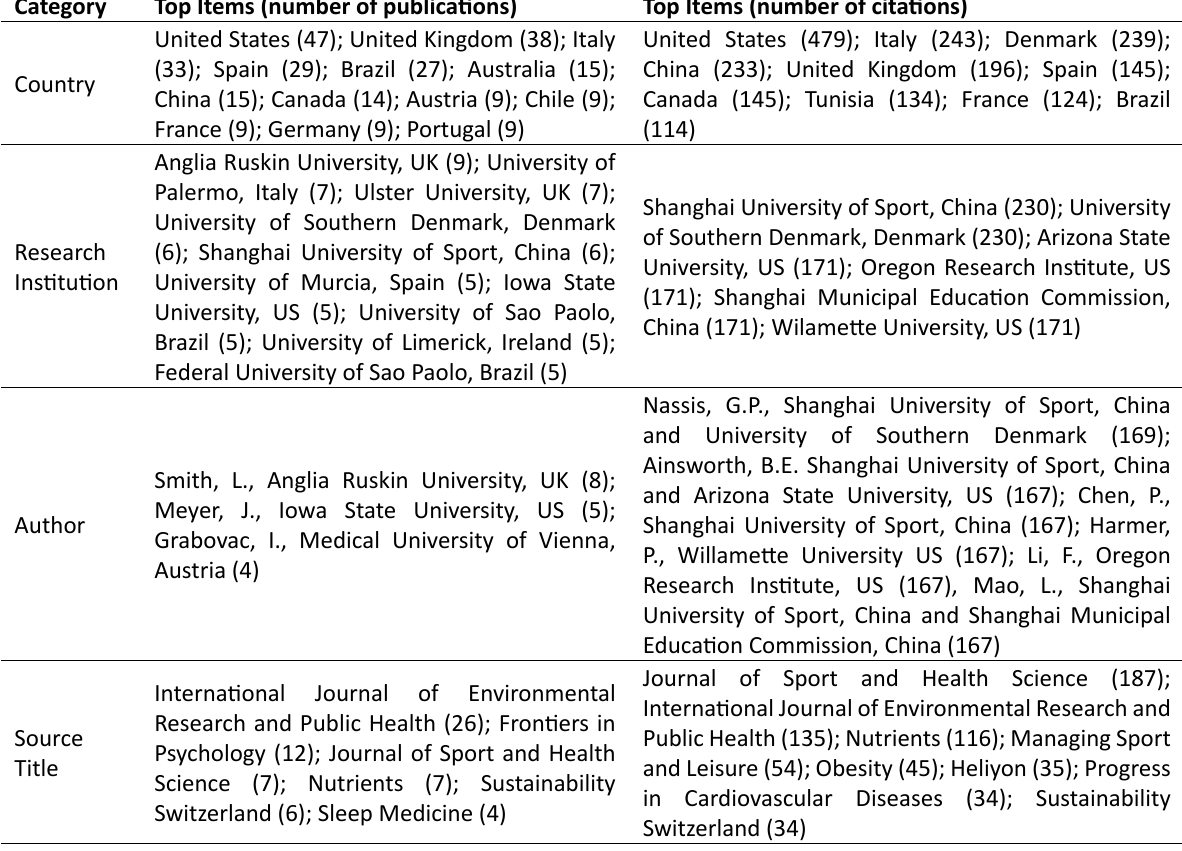
Table 2. General publication profiling of research on physical activity in the COVID-19 context Category Top Items (number of publications) Top Items (number of citations)